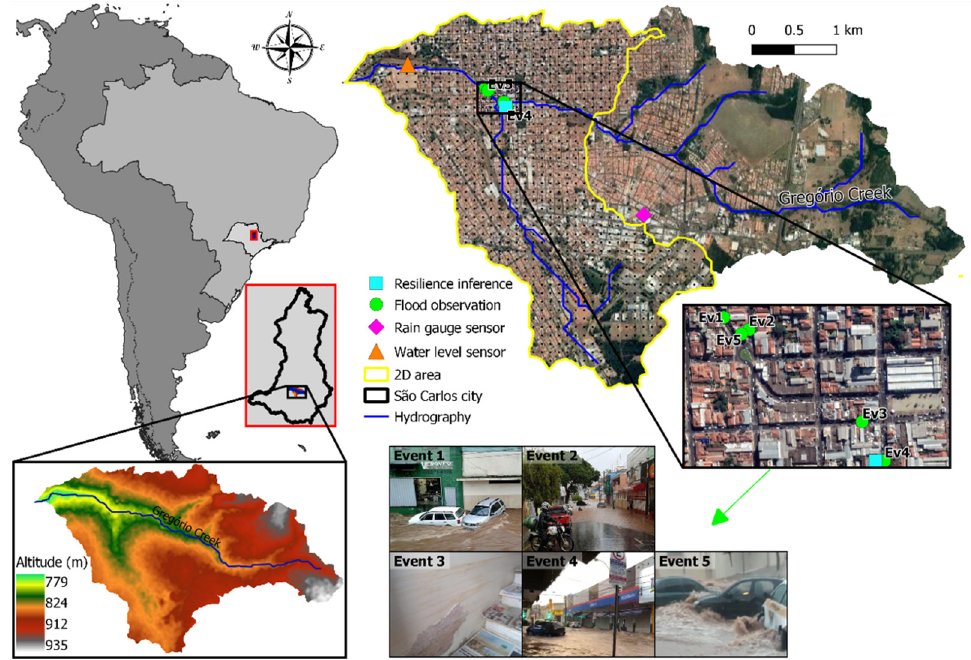
Figure 1. Gregório Creek Catchment in the city of São Carlos, São Paulo State, Brazil. The photo ‐ Figure 1. Greg ó rio Creek Catchment in the city of S ã o Carlos, S ã o Paulo State, Brazil. The photographs graphs show citizen science data collected during flood events that occurred in the area. show citizen science data collected during flood events that occurred in the